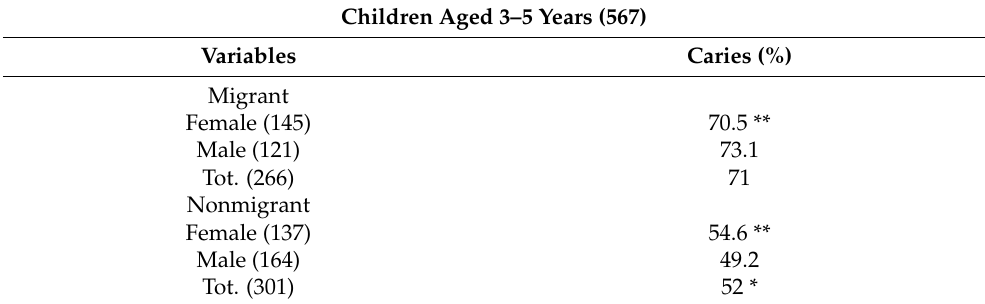
Table 1. Prevalence of caries associated with gender in migrant and nonmigrant groups.